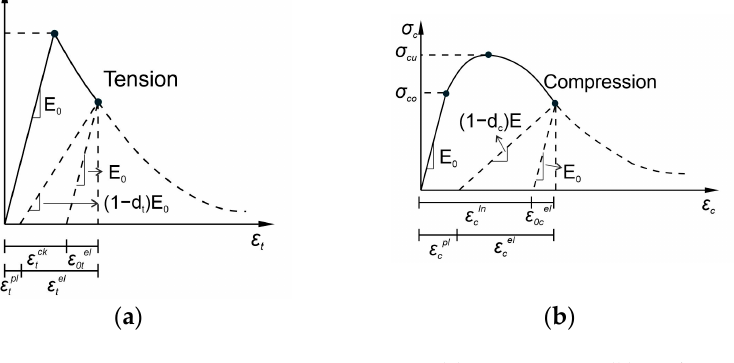
Figure 8. Tension ( a ), compression ( b ), and uniaxial cyclic ( c ) behavior of the CDP. Uniaxial tensile and compressive stresses ( σ t and σ c ) are defined as